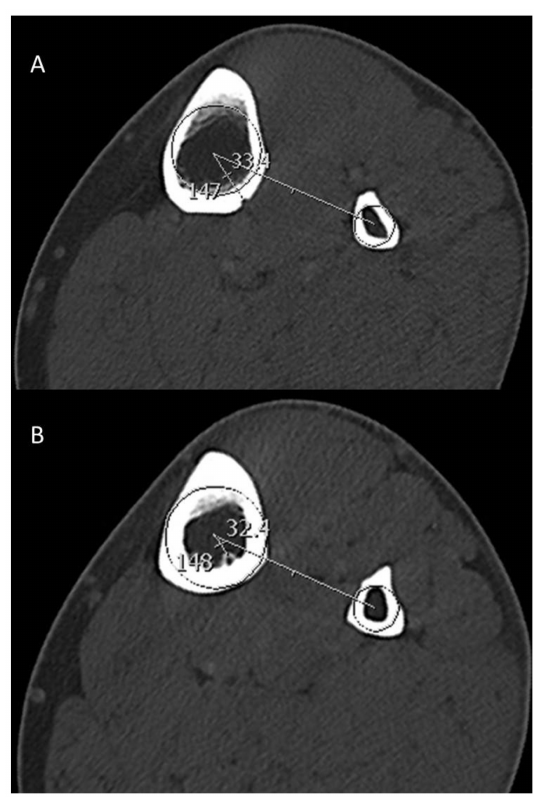
Figure 3. Axial reformatted images in bone window indicating the angular position of the outer foramen of TNAC on the outer cortex ( A ) and the angular position of the inner foramen on the inner cortex ( B ). The angular position is defined by a line connecting the two centers of the tibia and fibula and an intersecting line connecting the center of the tibia to the respective